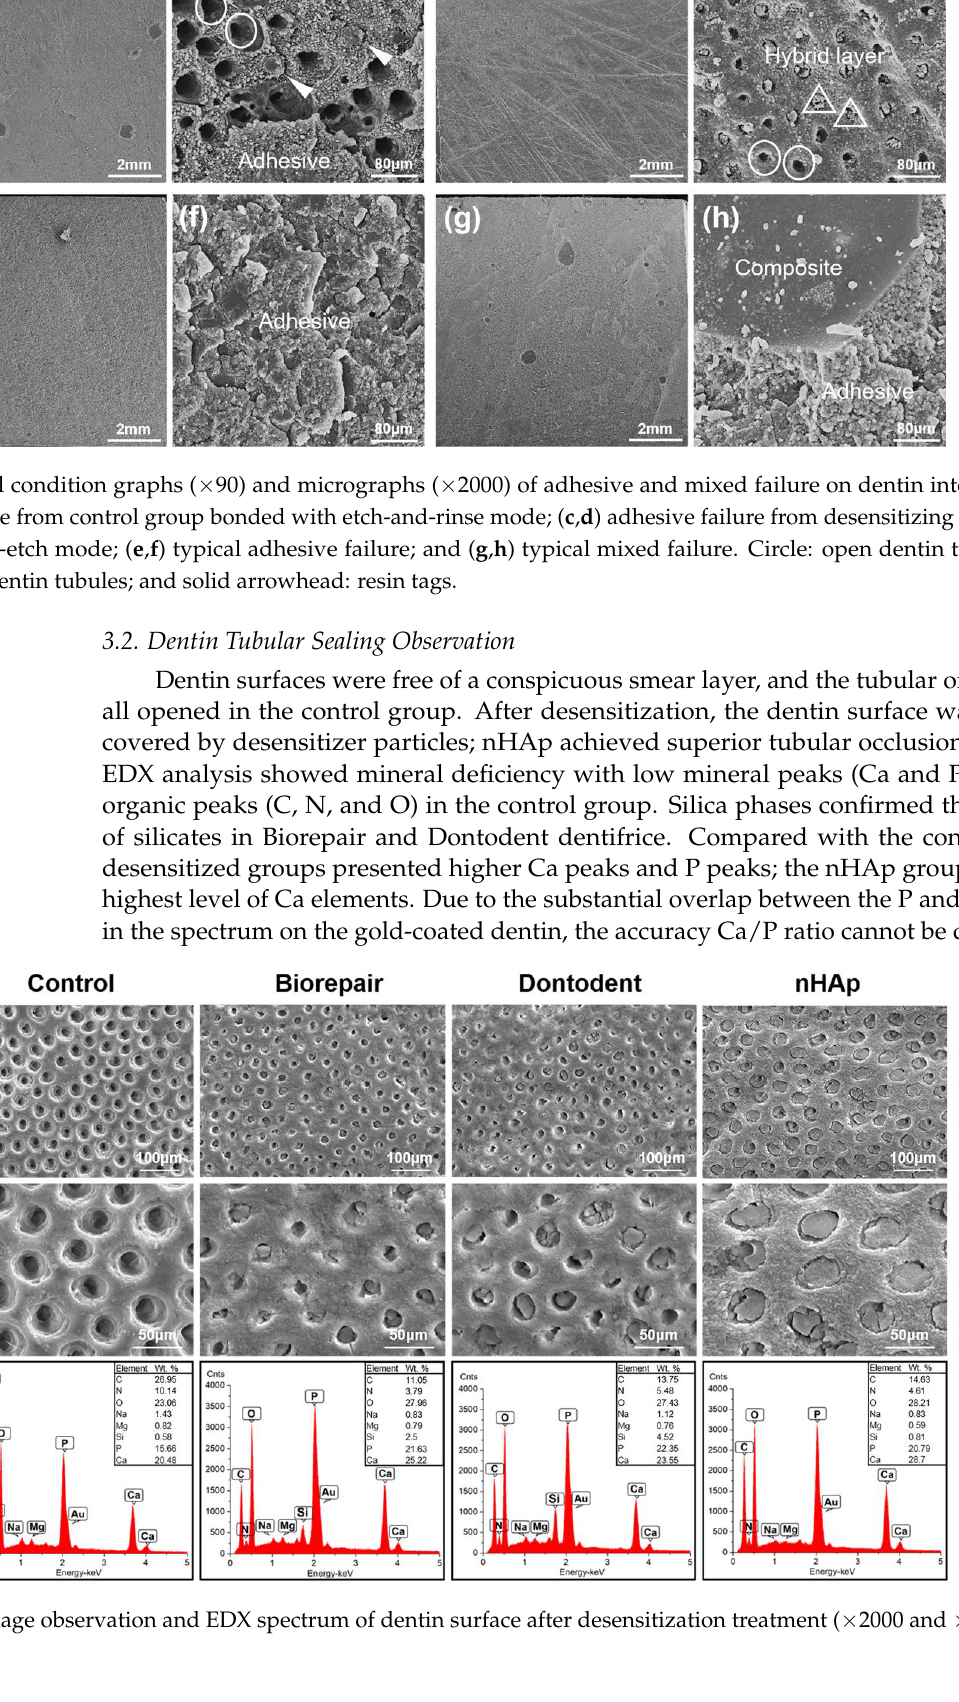
Figure 2 . Micro-tensile bond strength and failure mode. ( a ) Effects of desensitizer types and bonding modes on bond strength of universal adhesives. Different superscript uppercase letters indicate significant differences with etch-and-rinse mode ( p < 0.05). Different superscript lowercase letters indicate significant differences with self-etch mode ( p < 0.05). * denotes a significant difference between the etch-and-rinse mode and self-etch mode ( p < 0.05). ( b ) Failure mode distribu- tion of fracture specimens. M: mixed failure; A: adhesive failure; CD: cohesive failure within the dentin; and CC: cohesive failure within the composite resin.